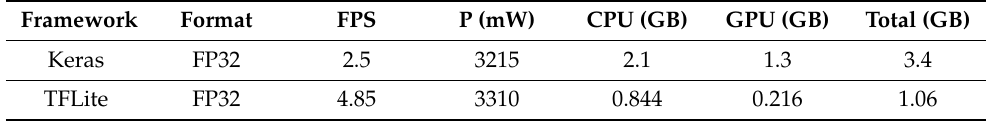
Table 4. Overall performance of the proposed FER system using different deep learning frameworks on Jetson